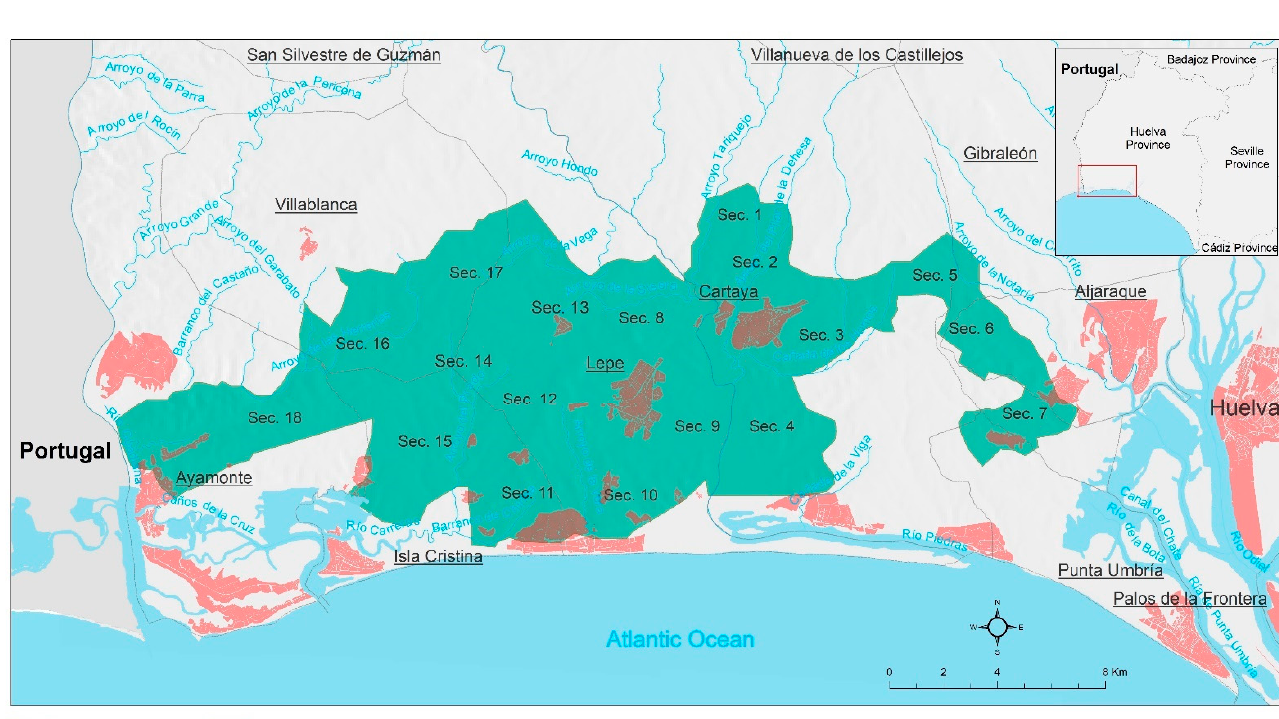
Irrigable Area (ha)